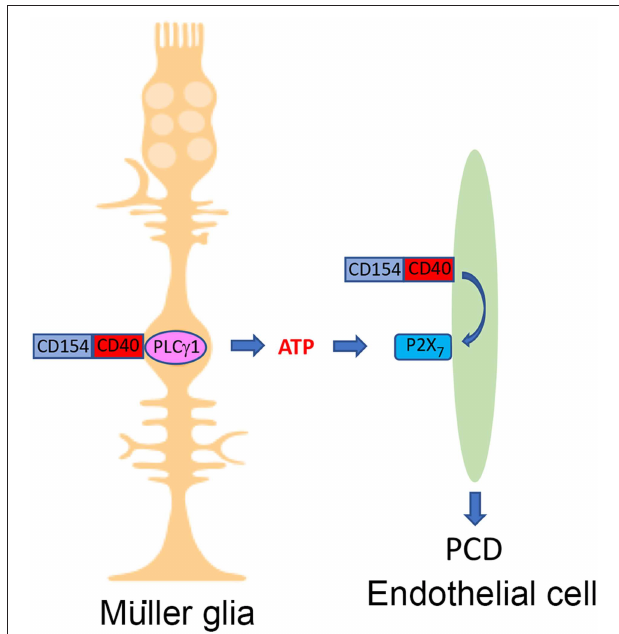
FIGURE 2 | The CD40-ATP-P2X 7 pathway links cellular responses in Müller glia with programmed cell death of bystander retinal endothelial cells in DR. Blood levels of CD154 and expression of CD40 on Müller glia are increased in diabetes. CD40 ligation in Müller glia causes PLC γ 1 (PLC)-dependent secretion of extracellular ATP. CD40 ligation in retinal endothelial cells upregulates P2X 7 receptor, making these cells susceptible to P2X 7 -induced programmed cell death. Created in part with